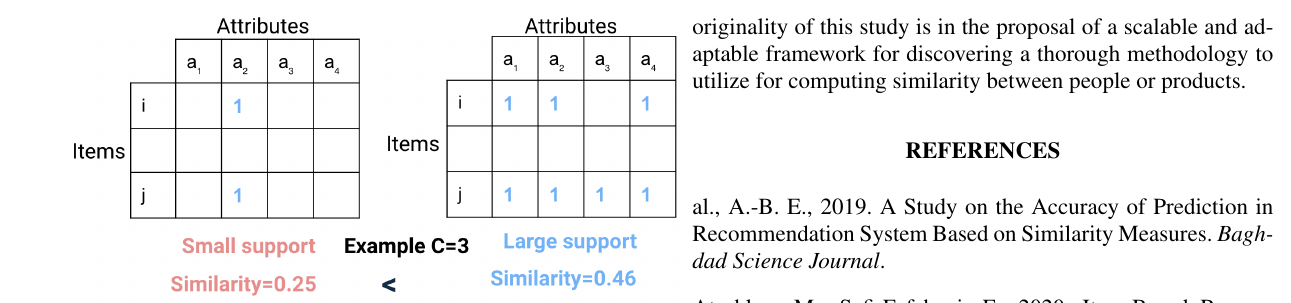
Figure 7. Scenario case for shrinking the cosinus similarity